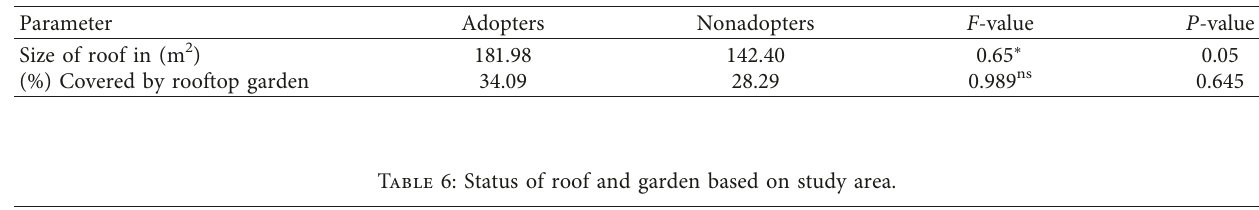
Table 5: Status of roof and garden as per adopters vs. nonadopters.